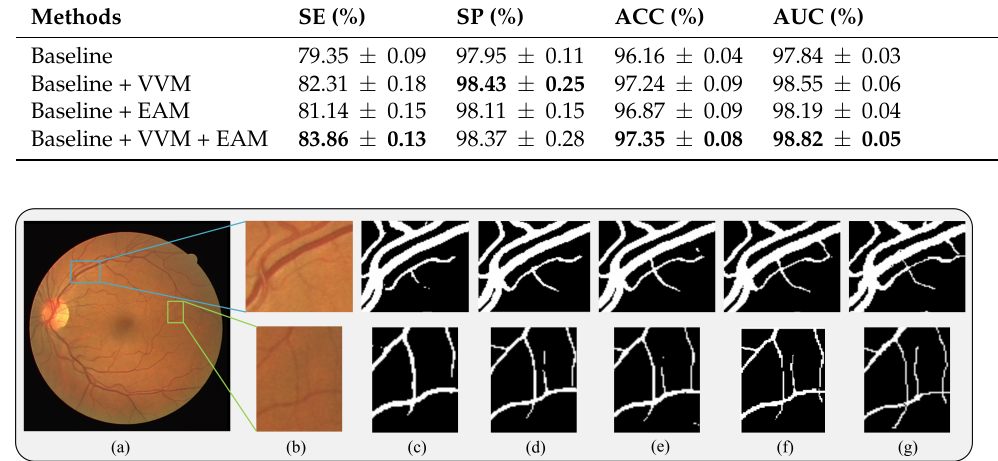
Figure 5. Some typical visual results for different methods in our ablation study on the DRIVE dataset. ( a ) Original image, ( b ) detailed view, ( c ) Baseline, ( d ) Baseline + VVM, ( e ) Baseline + EAM, ( f ) Baseline + VVM + EAM, ( g ) ground